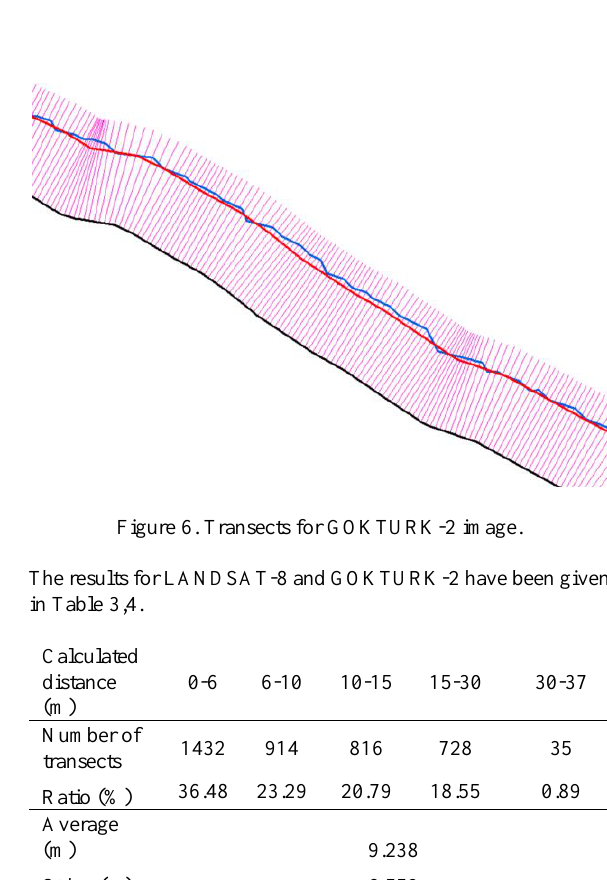
Figure 5. Transects for LANDSAT-8 image.